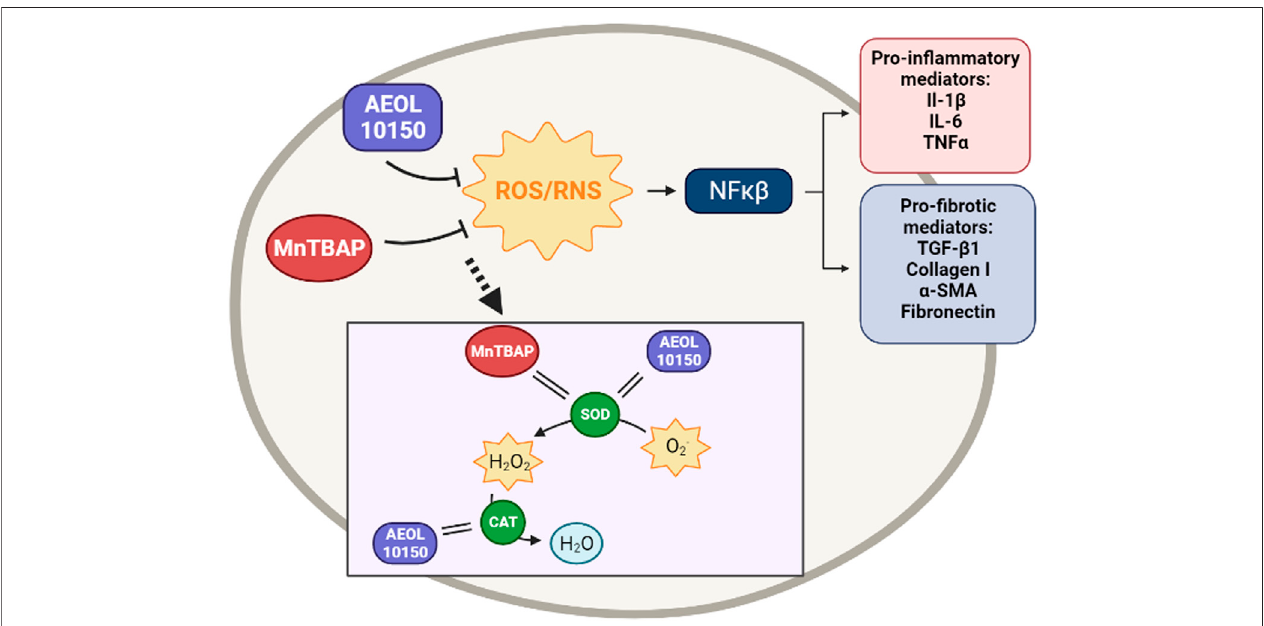
FIGURE 6 | Simpli fi ed diagram of the principal molecular mechanisms of the SOD mimetics AEL10150 and MnTBAP. α SMA: alpha smooth muscle actin; CAT: catalase; IL-1 β : interleuquina 1beta; IL-6: interleuquina 6; NF κβ : nuclear factor kappa beta; ROS/RNS: reactive oxygen species/reactive nitrogen species; TGF- β 1: transforming growth factor beta 1; TNF α : tumoral necrosis factor alpha; SOD: supeoxide dismutase Created with Biorender.com.